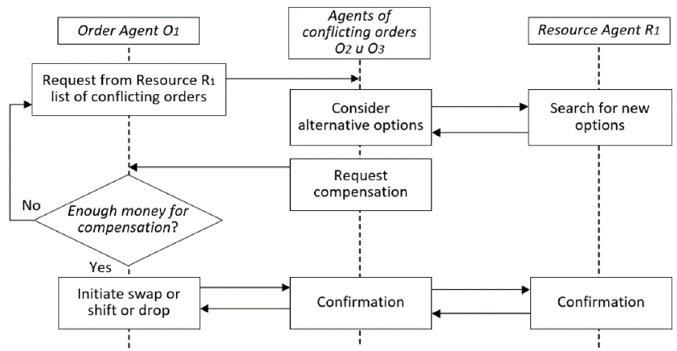
Figure 6. Reallocation of orders after negotiations.